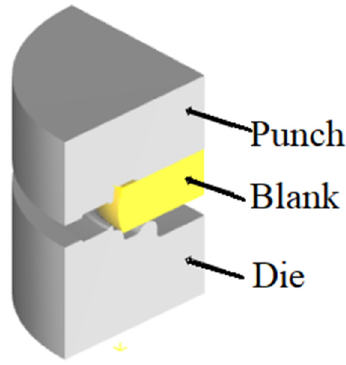
Figure 15. 3D model of the disc.